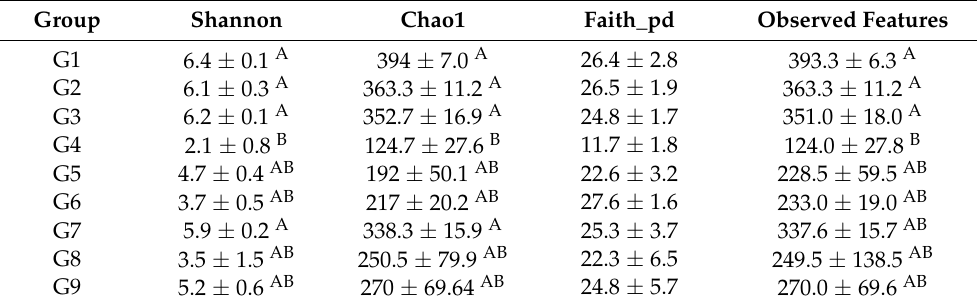
Table 1. Alpha-diversity indexes of fecal samples were obtained across the different groups after their respective intervention in phase 2 (treatment phase). Group Shannon Chao1 Faith_pd Observed Features